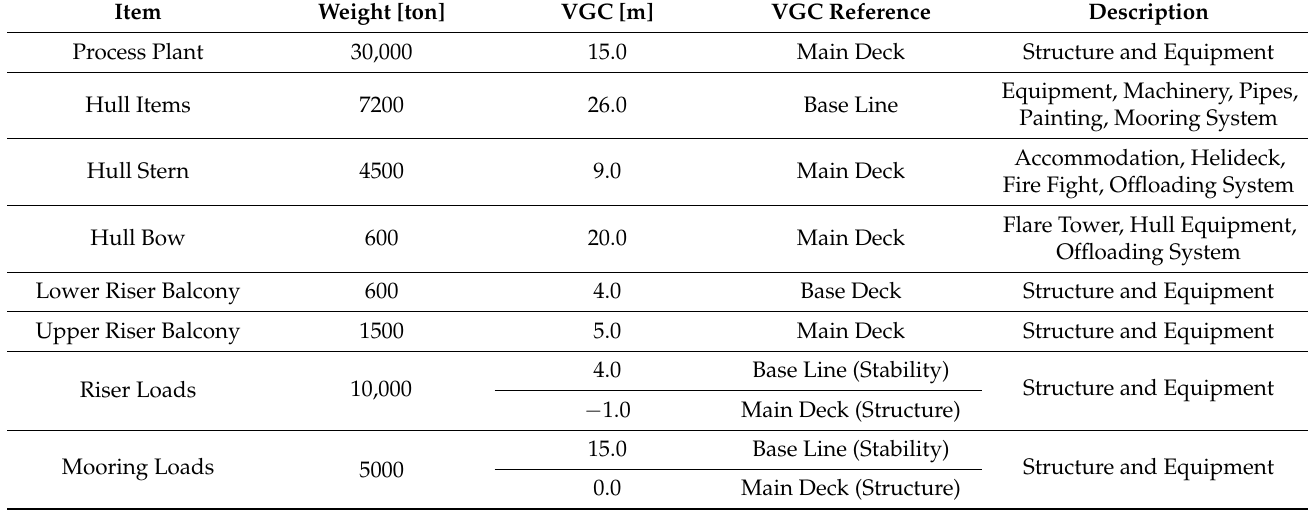
Table 1. Permanent loads to be considered in the mass model.